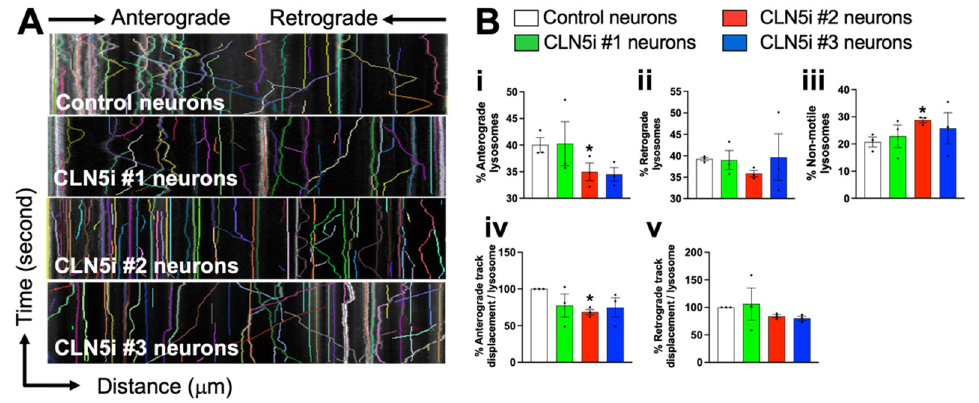
Figure 4. CLN5-deficient human neurons exhibit impaired lysosomal movement. ( A,B ) CLN5-deficient neurons (CLN5i #2 neurons) showed reduced percentage of anterograde lysosomes, increased percentage of non-motile neurons, and reduced anterograde track displacement compared to control neurons measured by confocal microscopy and kymograph analysis. n = 3, * p < 0.05.